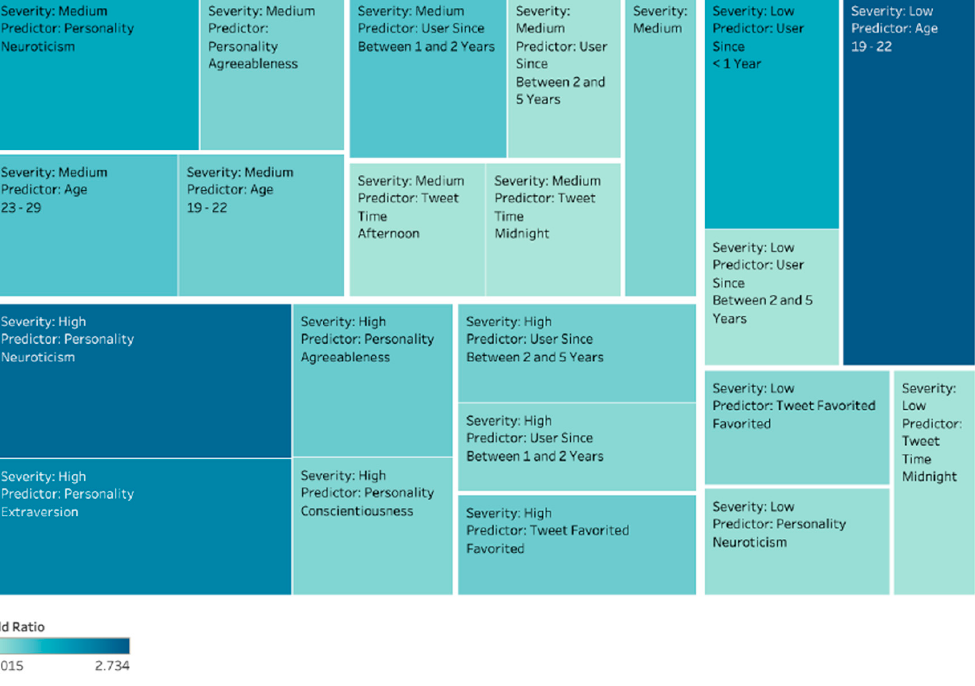
Figure 9. Multinomial Logistic Regression— Odds Ratio.